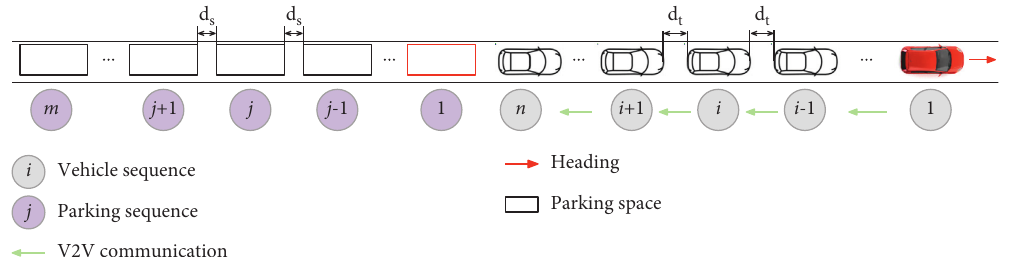
Figure 1: General platoon